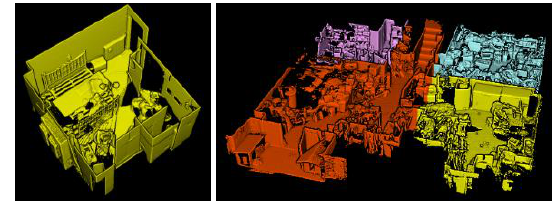
Figure 4. Noise in the point cloud: internal of a room.